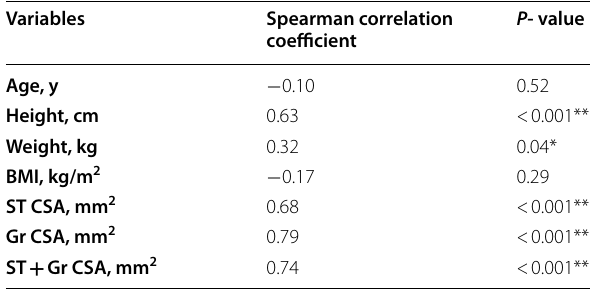
Table 3 Bivariate correlation analysis between HT autograft diameter and anthropometric and MRI